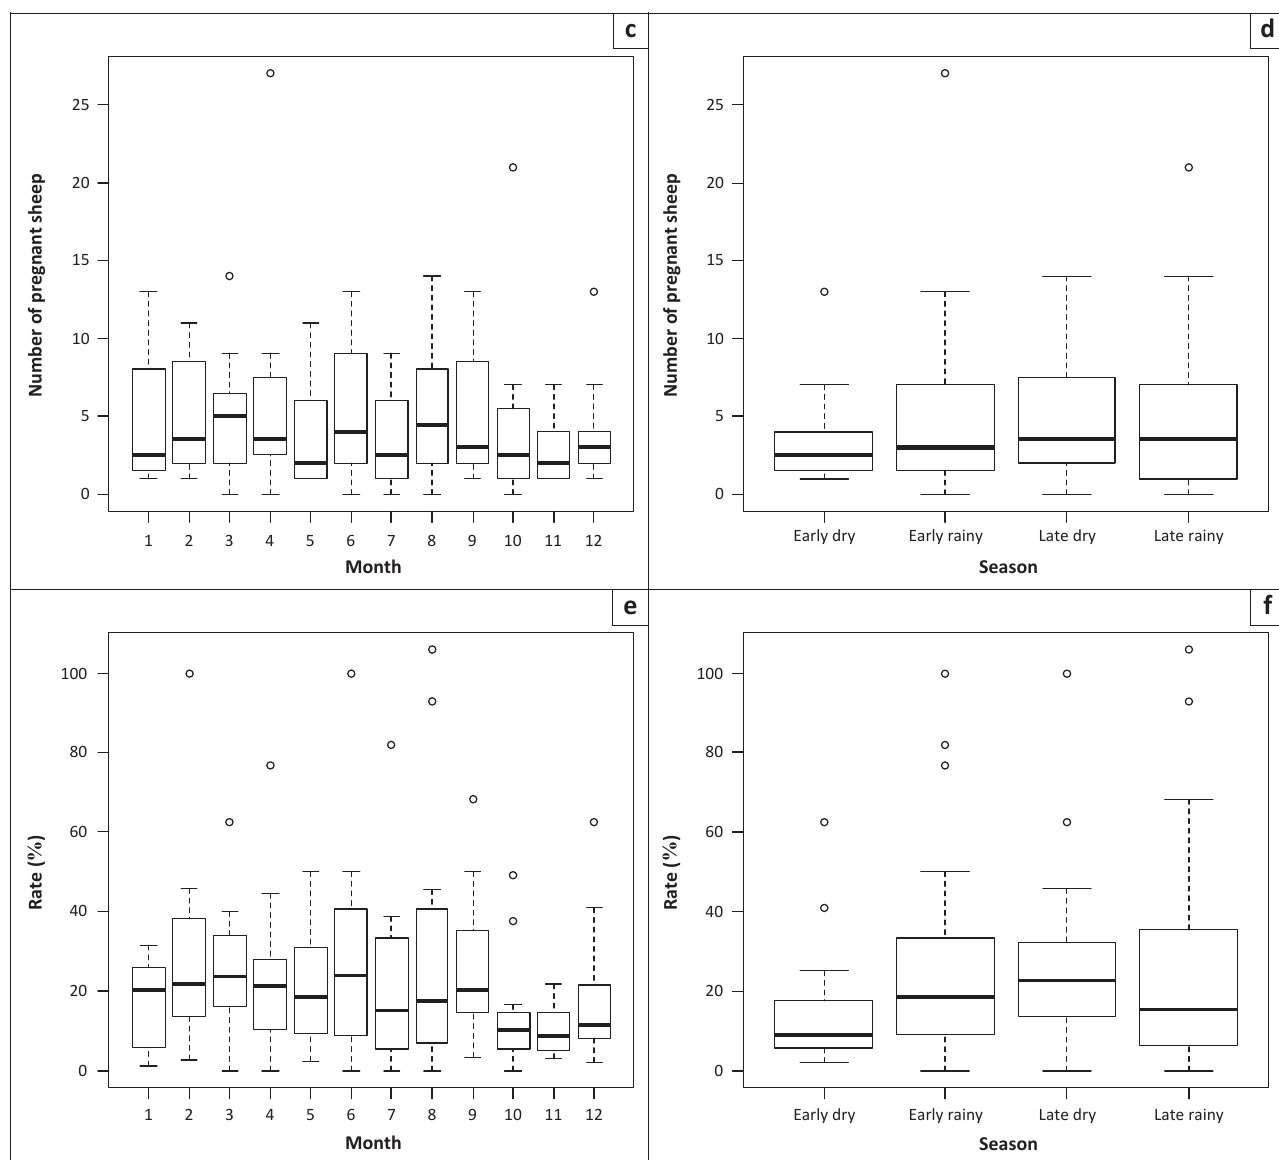
FIGURE 2-A2 (Continues...): Monthly and seasonal rate of throughput, slaughter of pregnant animals and foetal wastage for sheep, Minna Metropolitan Abattoir, Nigeria, during 2001–2012. (a) Monthly throughput for sheep, (b) seasonal throughput for sheep, (c) monthly slaughter of pregnant sheep, (d) seasonal slaughter of pregnant sheep, (e) monthly rate of foetal wastages in sheep and (f) seasonal rate of foetal wastages in